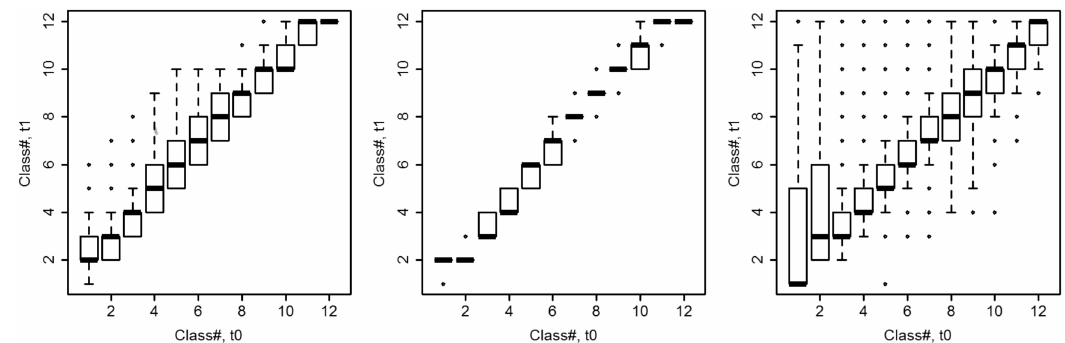
Figure 1. Transitions from the initial (Class#, t0) to the subsequent class (Class#, t1) in volume classes derived from permanent ( left ) and temporary plots ( middle ) and stem number classes derived from permanent plots ( right ). The thick horizontal lines depict the median, the bottom and top of the boxes the interquartile range between the 25th and 75th percentiles, the whiskers the lowest data within 1.5 times the interquartile range, and dots the data not included in categories